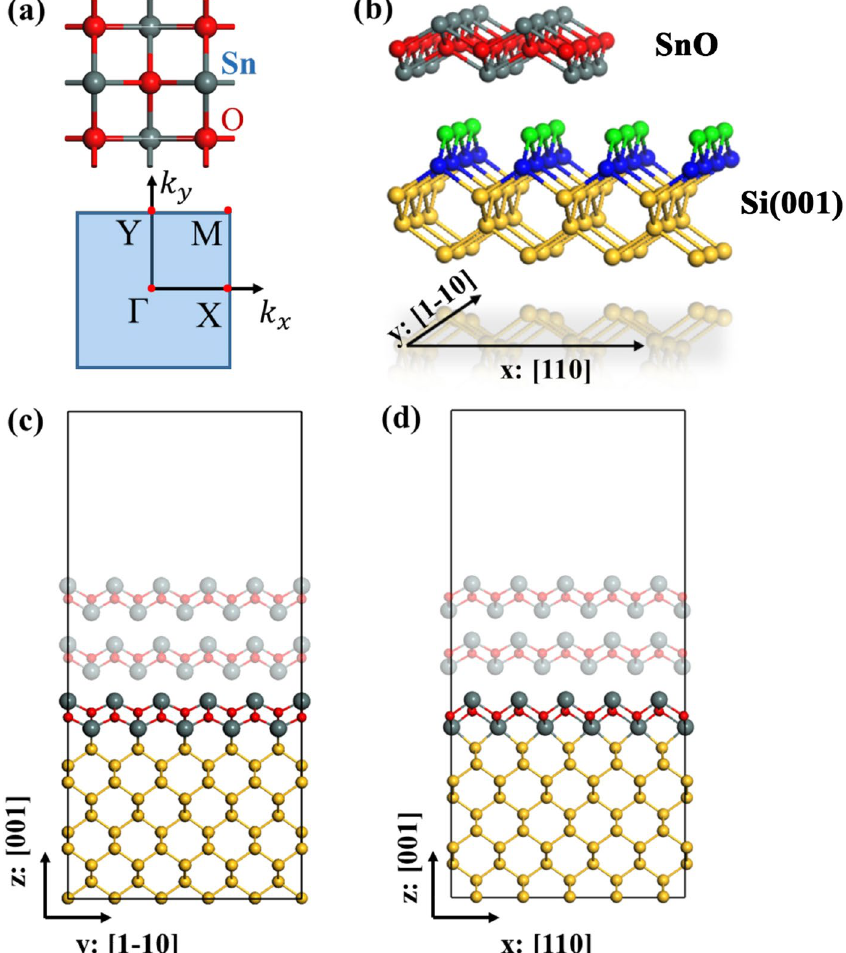
Figure 1. ( a ) The top view of SnO unitcell and two-dimensional Brillouin zone with selected high symmetry points. ( b ) 3D view of SnO layer over clean Si(001)-1 × 1 surface with the 1 st and 2 nd Si layers shown in green and blue respectively and the rest Si layers in yellow. ( c ) and ( d ) Schematics of most stable SnO/Si(001) structure viewed along x:[110] direction and y:[1–10] direction respectively. It is noted that the interfacial structure viewed along x is different from y due to the two-fold rotational symmetry of Si(001)